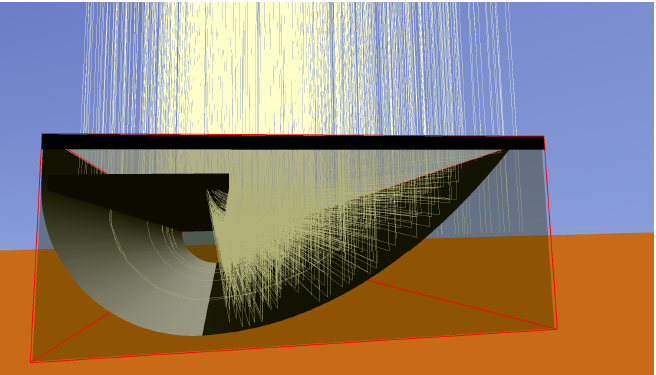
Figure 4. Concertation of solar radiation on the receiver and location of the focal point. Table 2. The features of the PowerCollector .